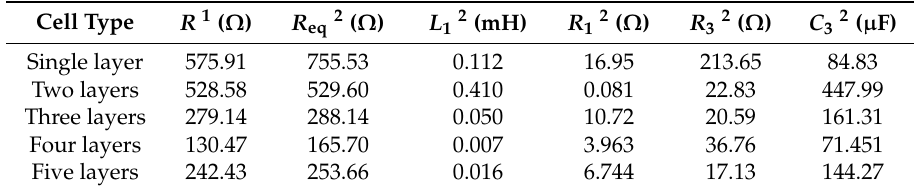
Table 1. Obtained parameters for half-textile DSSC cells with one to five layers of PEDOT: PSS in the counter electrode by spectral